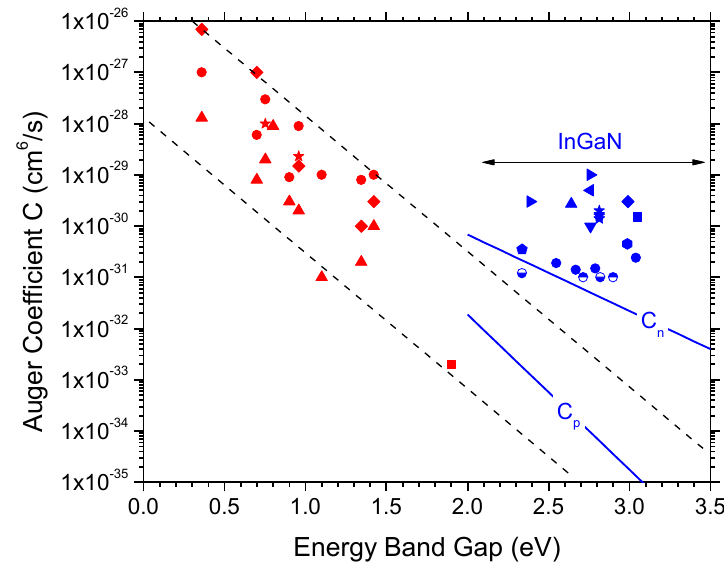
Figure 9. Published Auger coe ffi cients for various semiconductors as function of energy band gap. The InGaN data (blue symbols) contradict the steep decline with larger band gap observed with other semiconductors (red symbols). The blue lines are calculated for indirect Auger excitations within conduction bands (C n ) or valence bands (C p ) of bulk InGaN [83].